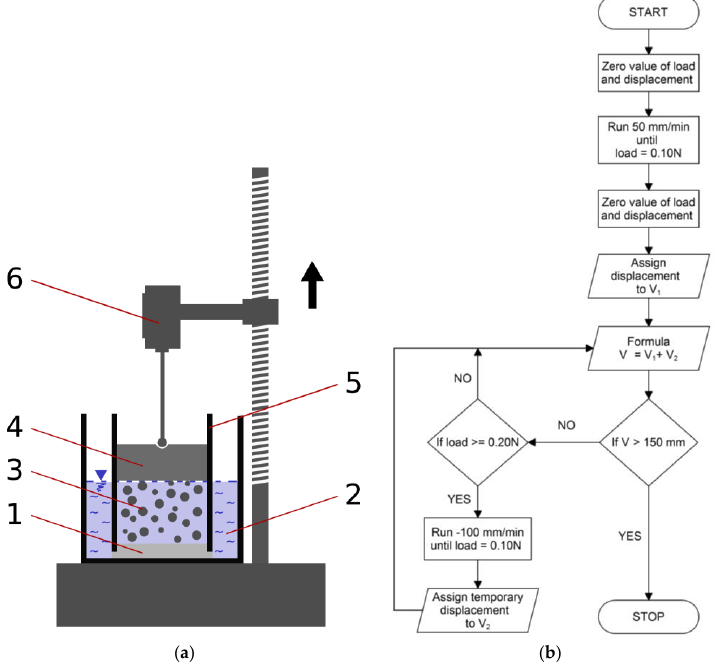
Figure 1. ( a ) Scheme of the test apparatus. (1) Porous rock, (2) outer cylinder with water, (3) superabsorbent polymer, (4) load, (5) inner cylinder, and (6) force sensor; ( b ) scheme of the test program procedure.